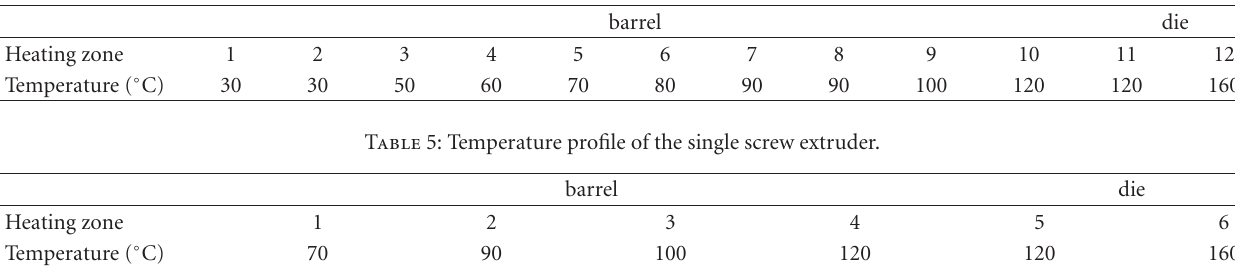
Table 4: Temperature profile of the twin screw extruder.